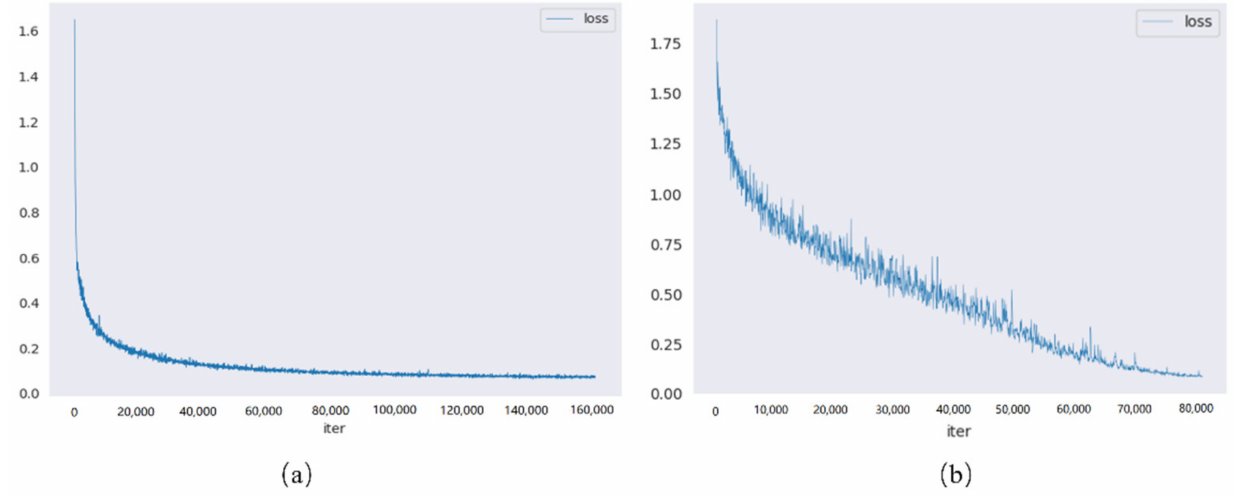
Figure 11. Training plots for the cropland extraction network in the dataset: ( a ) training decreasing loss curves in the Agriculture dataset, ( b ) training decreasing loss curves in the DeepGlobe